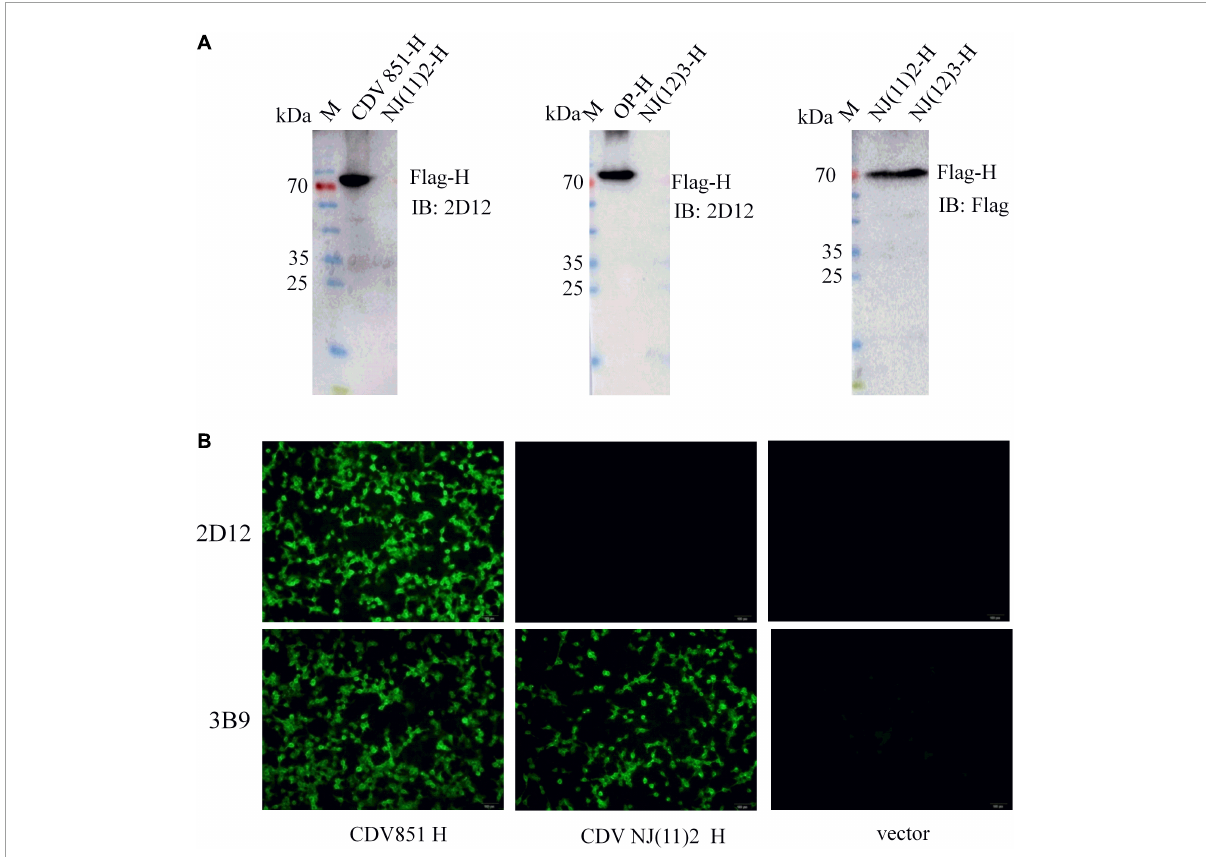
FIGURE2 Identification of the reactivity of mAb 2D12 with H protein of different canine distemper virus (CDV) strains. (A) The reactivity of mAb 2D12 with H protein of different CDV strains by western blot. 293T cells were transfected with pCA-H plasmids of CDV 851, NJ(11)2, NJ(12)3, and OP strains, after 24 h post-transfection, the cell lysates were prepared and subjected to western blot analysis with mAb 2D12 and control Flag antibody. (B) The reactivity of mAb 2D12 with H protein of different CDV strains by immunofluorescence assay (IFA). 293T cells were transfected with pCA-H plasmids of CDV 851 and NJ(11)2 strains, after 24 h post-transfection, the cell lysates were fixed, followed by incubation with mAb 2D12, 2B9, and FITC-conjugated anti-mouse IgG antibody. The cells were observed under the fluorescence